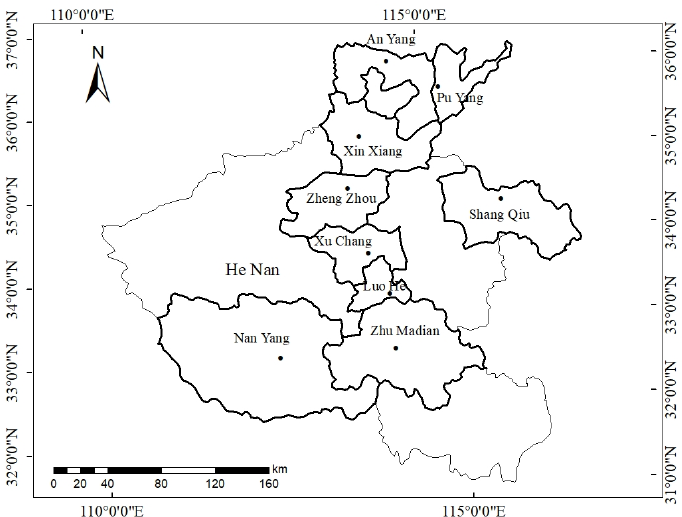
Figure 6. Producing areas of winter wheat that went through the verification in Henan province.